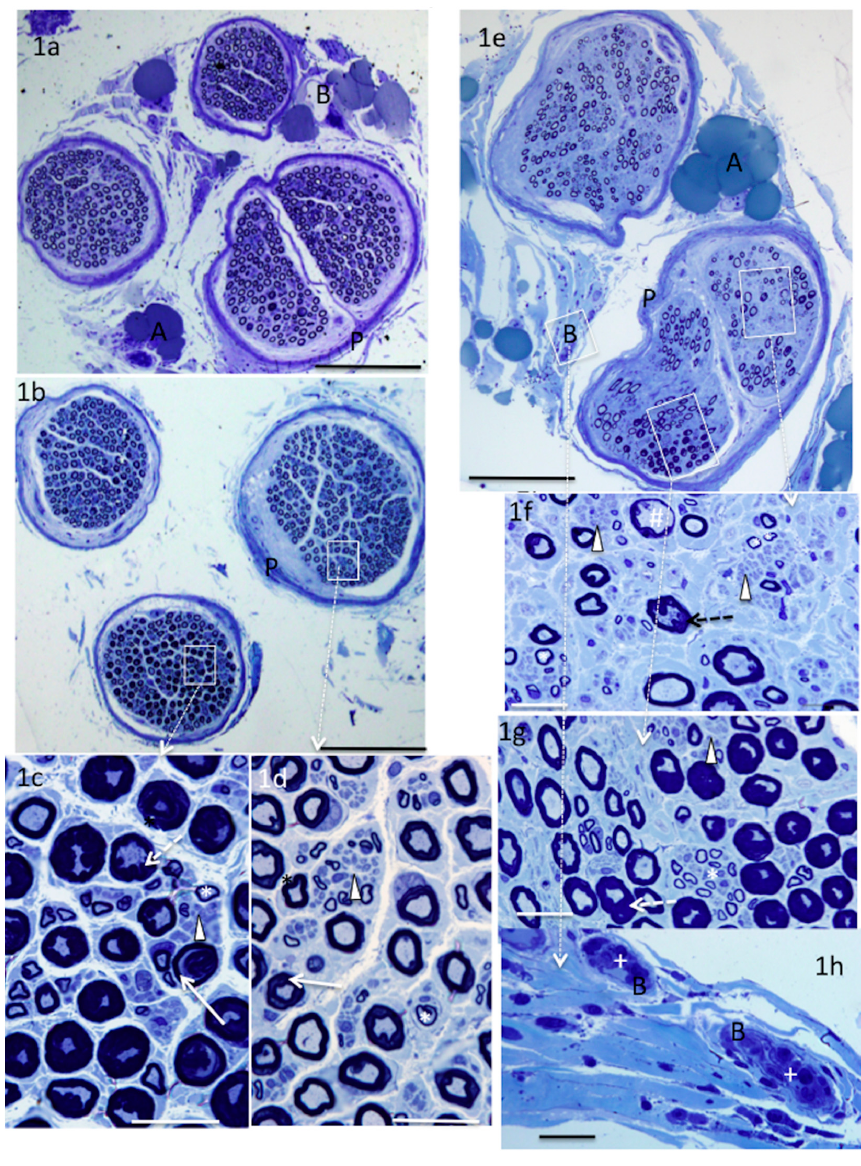
Figure 1. Methylene blue-stained sections from supinator nerves. Supinator nerves showed morphologic abnormalities in two patients. Normal nerves showed fascicles containing large myelinated axons of relatively uniform size, myelin thickness and orientation ( a ); an abnormal nerve ( b ) with one fascicle mostly occupied by axons surrounded by markedly thickened; split or folded myelin ( c ) and one fascicle less affected ( d ). A severely affected nerve has a reduced large myelinated axon density ( e , f ) in addition to thickened, folded, distended myelin ( f , g ). Note the groups of small unmyelinated axons (arrowheads), small thinly myelinated axons (*), thinned myelin (#), intravascular mononuclear cells (+), blood vessels (B), adipose cells (A), perineurium (P), folded myelin (dashed arrows) split myelin (arrows). White boxes highlight regions of higher magnification bar = 200 μ m ( a , b , e ), 20 μ m ( c , d , f – h ).